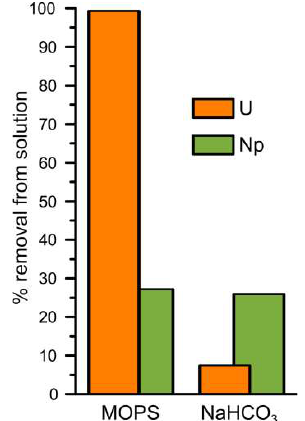
Figure 1. The percentage of removal of uranium and neptunium from solution during the MOPS and NaHCO 3 experiments after two weeks of reaction with magnetite.